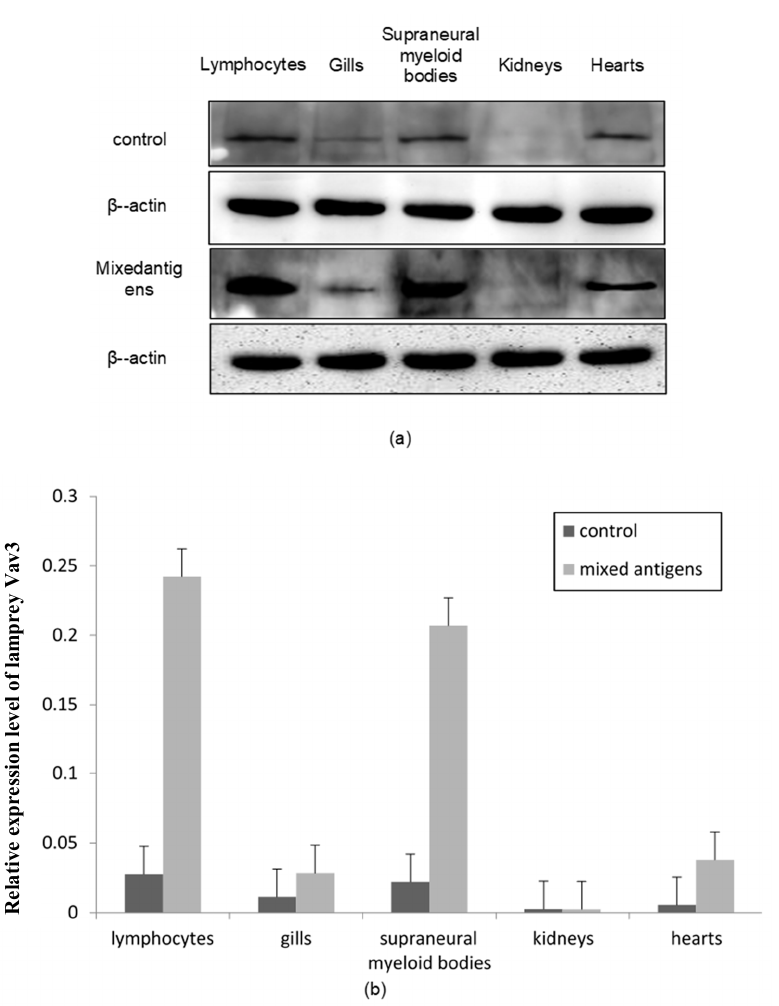
Figure 4. The relative expression levels of the lamprey vav3 mRNA in immune-related tissues before and after challenged by mixed-antigens. The lamprey vav3 mRNA levels were determined in immune-related tissues by using real-time quantitative PCR (Q-PCR) with an internal control, lamprey gapdh . The stimulated group was challenged with the mixed pathogens. The significant differences in lamprey vav3 mRNA expression between the stimulated and the corresponding control groups are indicated with asterisks, *: p < 0.05, **: p < 0.01.